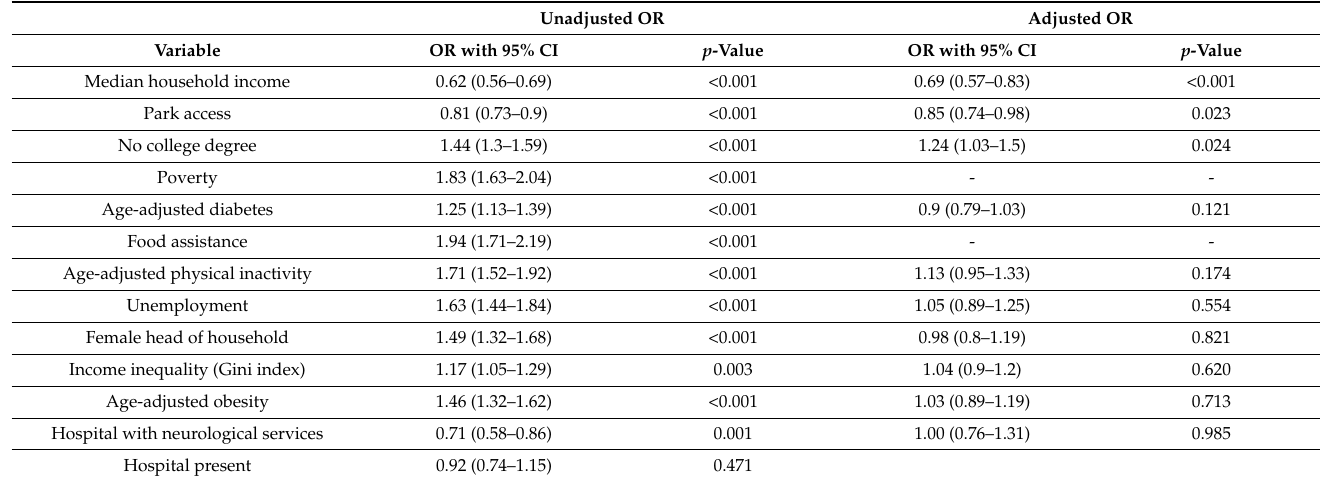
Table 3. Univariate and multivariate binomial generalized linear mixed model analyses for stroke death rate (SDR) per 100,000, all ages, all races/ethnicities, and both genders.